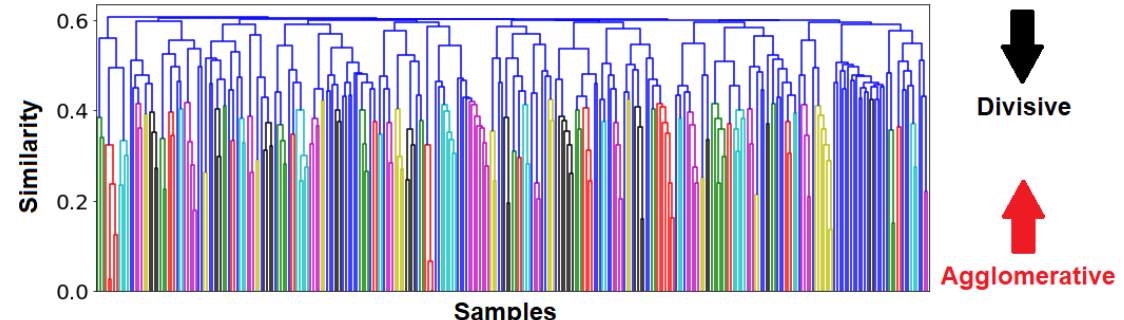
Figure A6. A dendrogram representation of hierarchical clustering. At the bottom, each individual sample belongs to its own cluster. Going up the dendrogram, samples are merged together based on the desired distance metric. At the top, all samples are merged into one giant